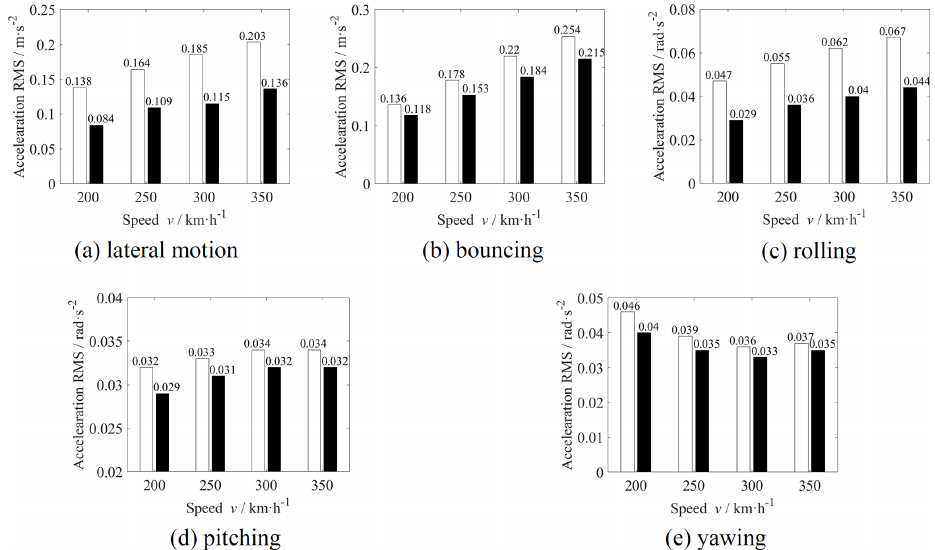
Figure 11. Acceleration rms values of different connection methods (white column – with MDOF DVA; black column – without DVA).